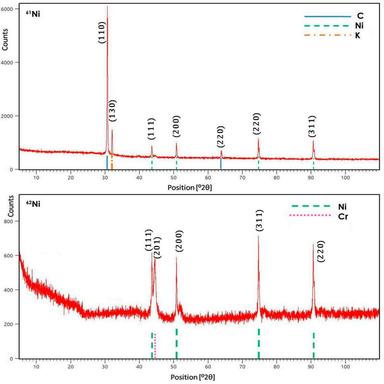
The XRD spectra of 61Ni(top) and 62Ni(bottom).